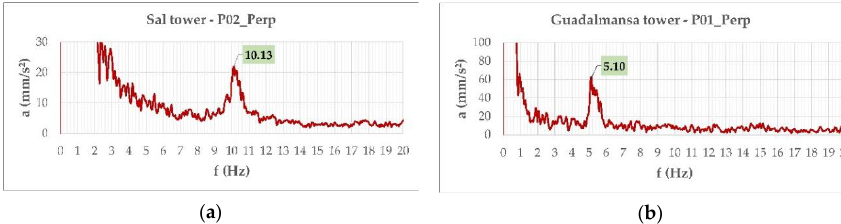
Figure 19. Frequency domain measurements from ambient vibration tests performed at ( a ) Sal tower (Casares, Malaga) and ( b ) Guadalmansa tower (Estepona, Malaga).